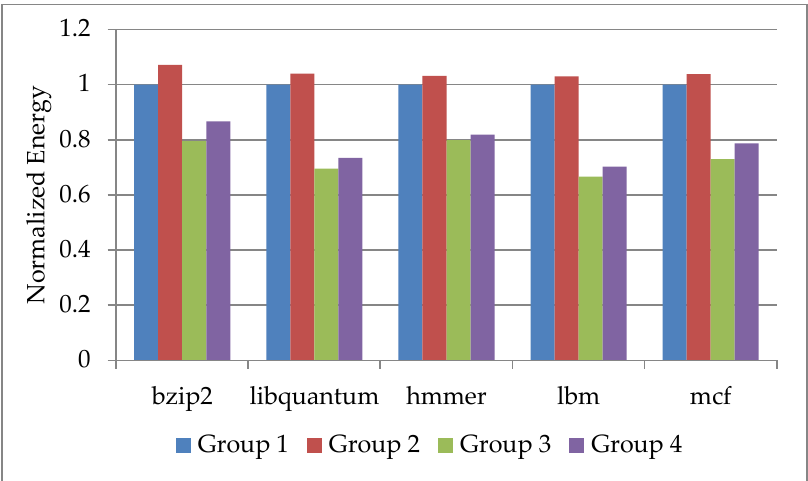
Figure 8. Comparison of Energy normalized to Group 1.